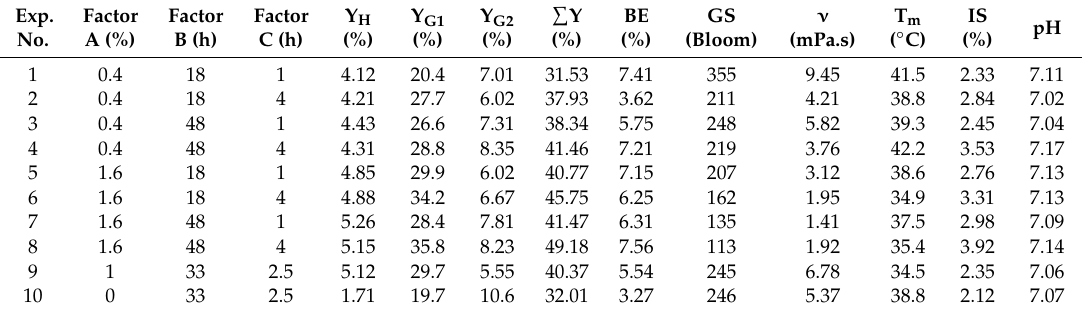
Table 1. The experimental design and the results of processing of chicken heads into gelatins. Exp.